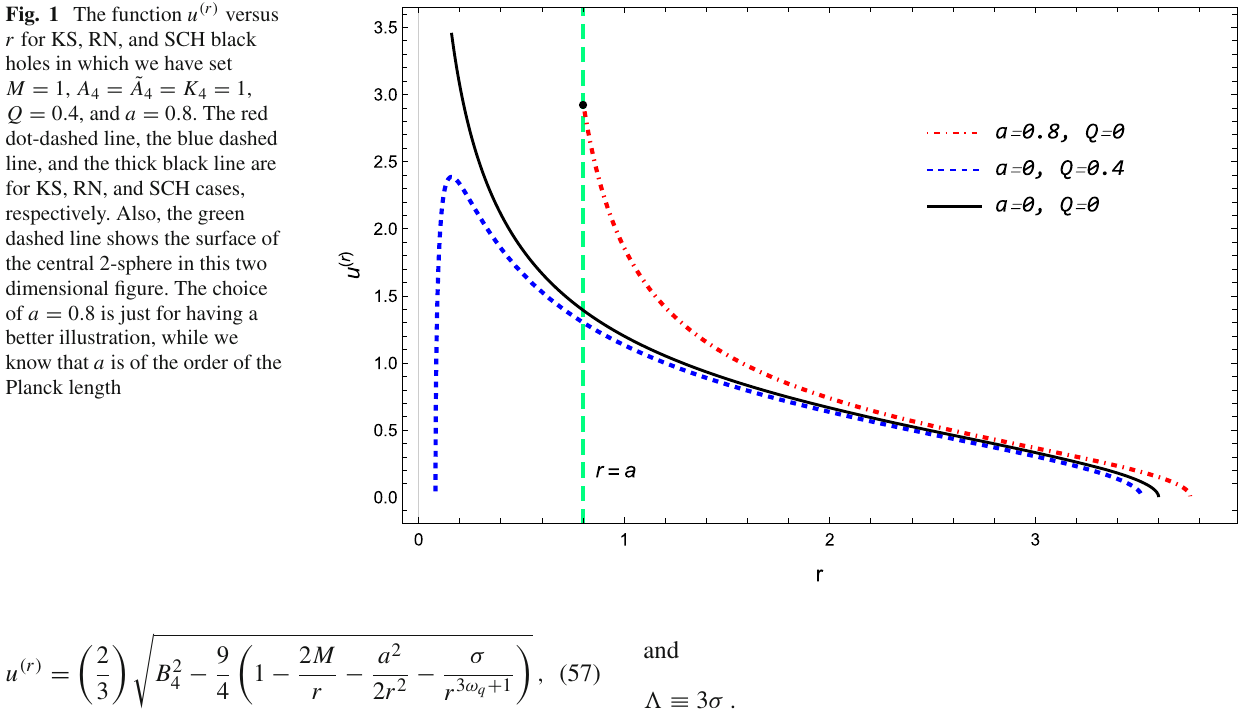
Fig. 1 The function u ( r ) versus r for KS, RN, and SCH black holes in which we have set M = 1, A 4 = ˜ A 4 = K 4 = 1, Q = 0 . 4, and a = 0 . 8. The red dot-dashed line, the blue dashed line, and the thick black line are for KS, RN, and SCH cases, respectively. Also, the green dashed line shows the surface of the central 2-sphere in this two dimensional figure. The choice of a = 0 . 8 is just for having a better illustration, while we know that a is of the order of the Planck